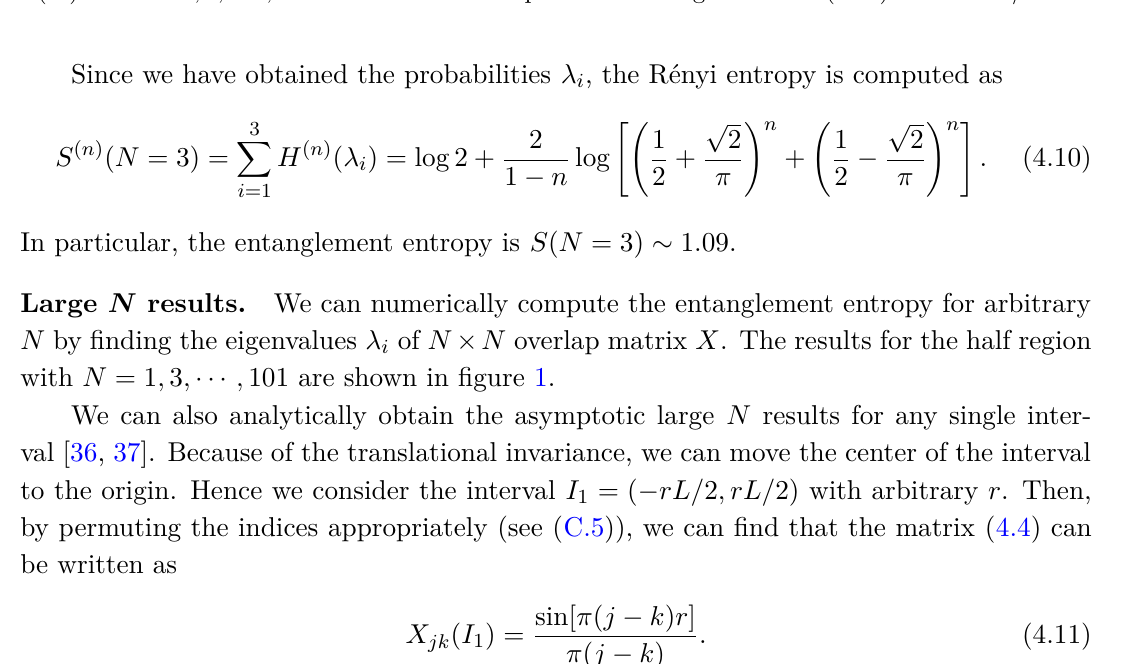
Figure 1 . Entanglement entropy for the half region. The red dots are the entanglement entropy S ( N ) for N = 1 , 3 , · · · , 101 . The blue curve represents the large N result (4.14) with r = 1 / 2